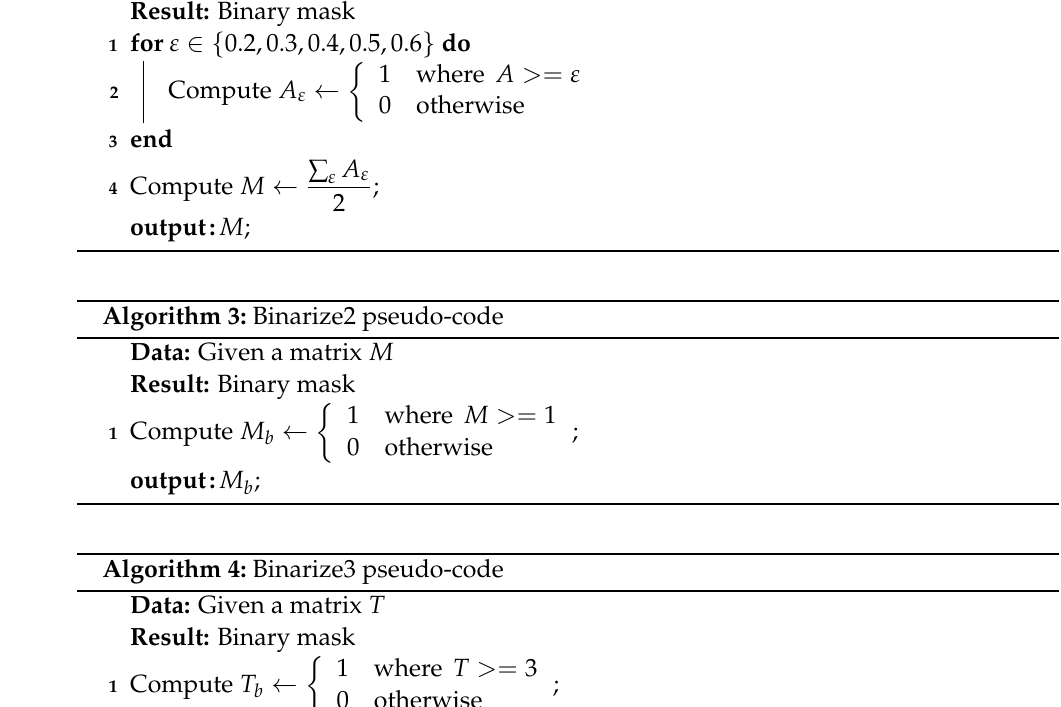
Algorithm 2: Binarize1 pseudo-code